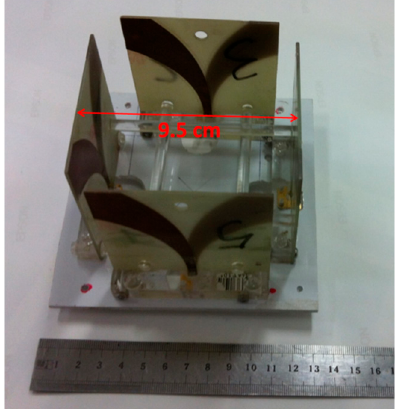
Figure 2. Polarimetric antenna array consisting of four Vivaldi antennas.